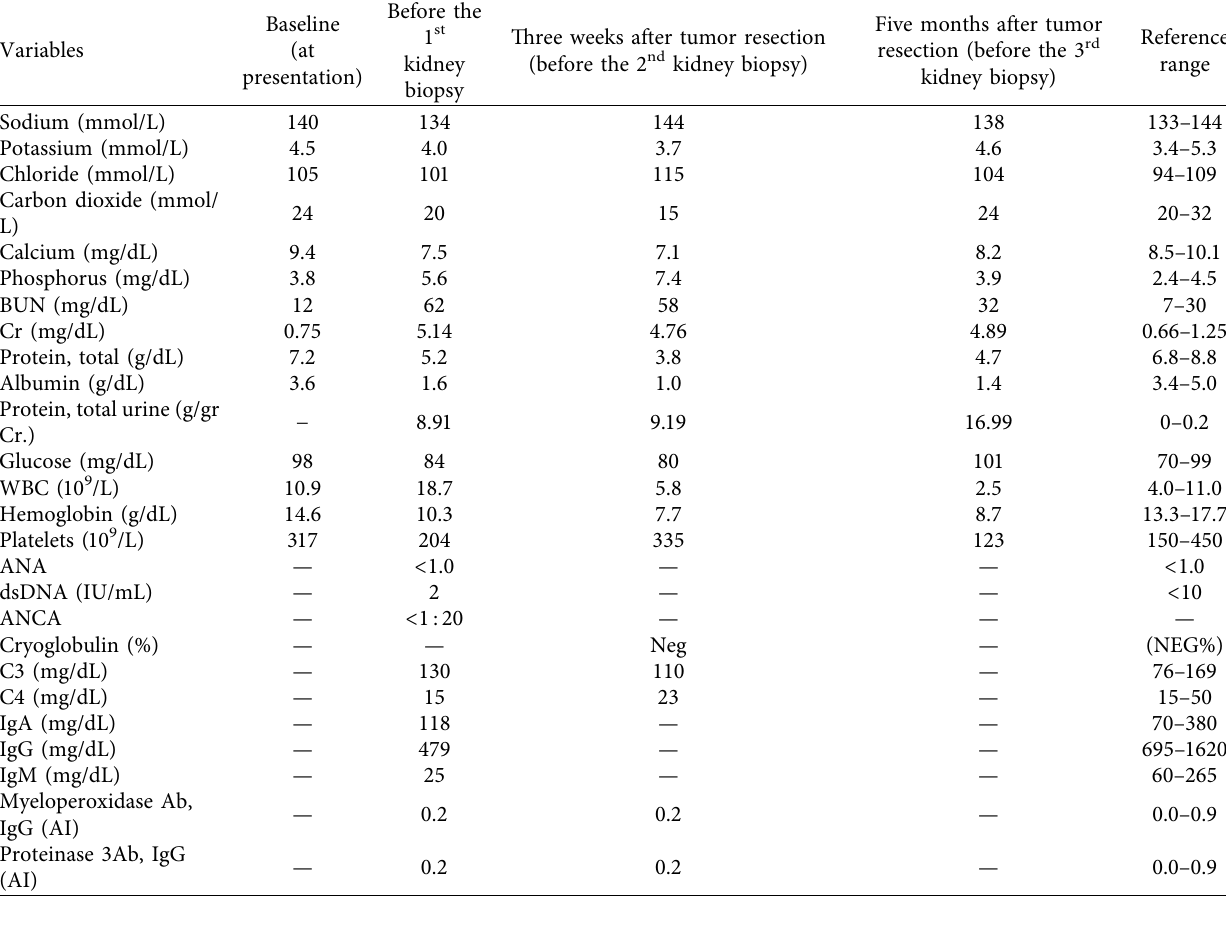
Table 1: Laboratory results before each kidney biopsy and after tumor resection.